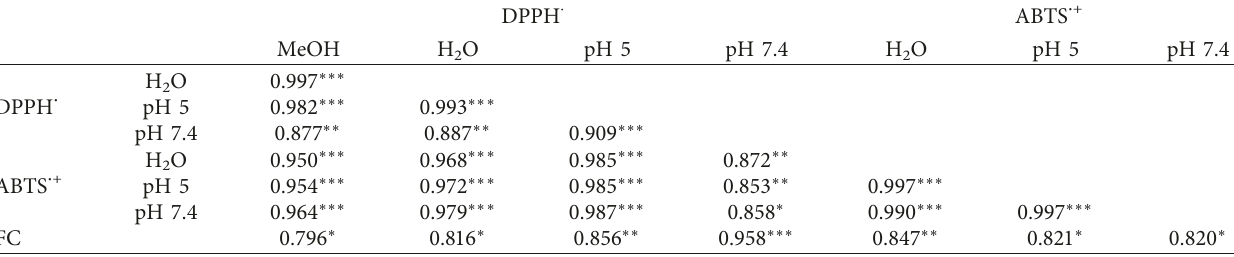
Table 3: Values of the Pearson correlation coefficient for correlation between AOPs determined in different antioxidant assays. DPPH